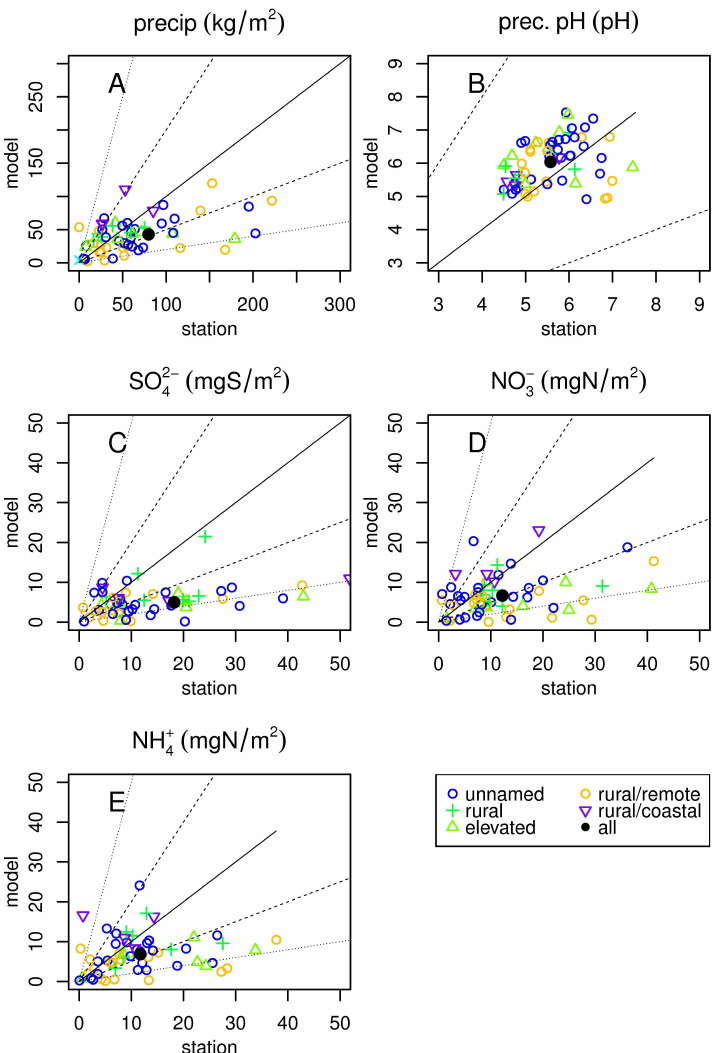
Fig. 8. Scatterplots of accumulated precipitation (A) , rain pH (B) , and wet deposited mass of SO 2 − hollow symbol represents the comparison between the measured mass total (average in case of pH), over the simulation period against the modeled one at a single station. Symbols are categorized according to a station representativeness classification by Henne et al. (2010), which is shown by different colors/symbols. Filled black circles represent the arithmetic mean over all comparisons. Lines are drawn to help estimate over/underestimation factors: solid=1:1, dashed=2:1 and